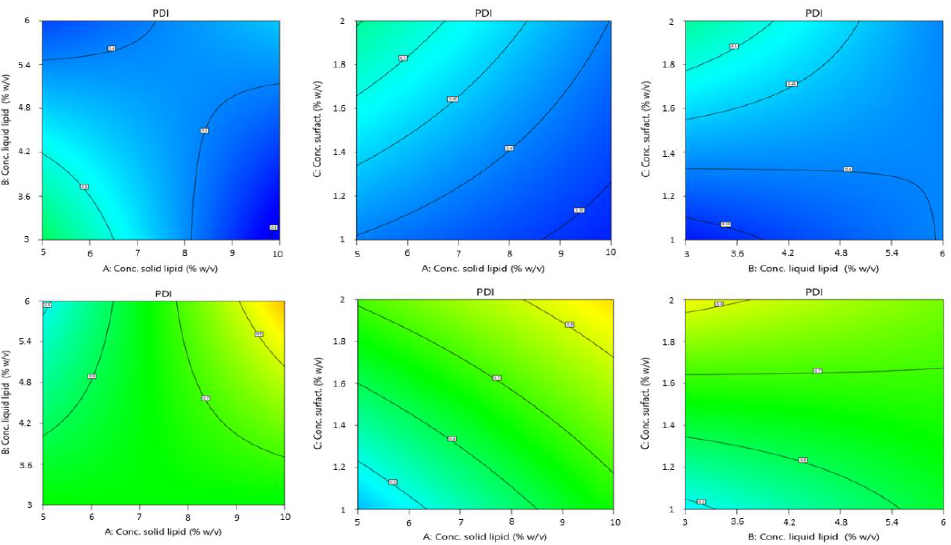
Figure 4. Contour plot of the effect of independent variables (from left to right: solid lipid concn. vs. liquid lipid concn., solid lipid concn. vs. surfactant concn., and liquid lipid concn. vs. surfactant concn.) on the PDI of NLCs using Softisan ® 100 (top) and Gelucire ® 44/14 (bottom row).